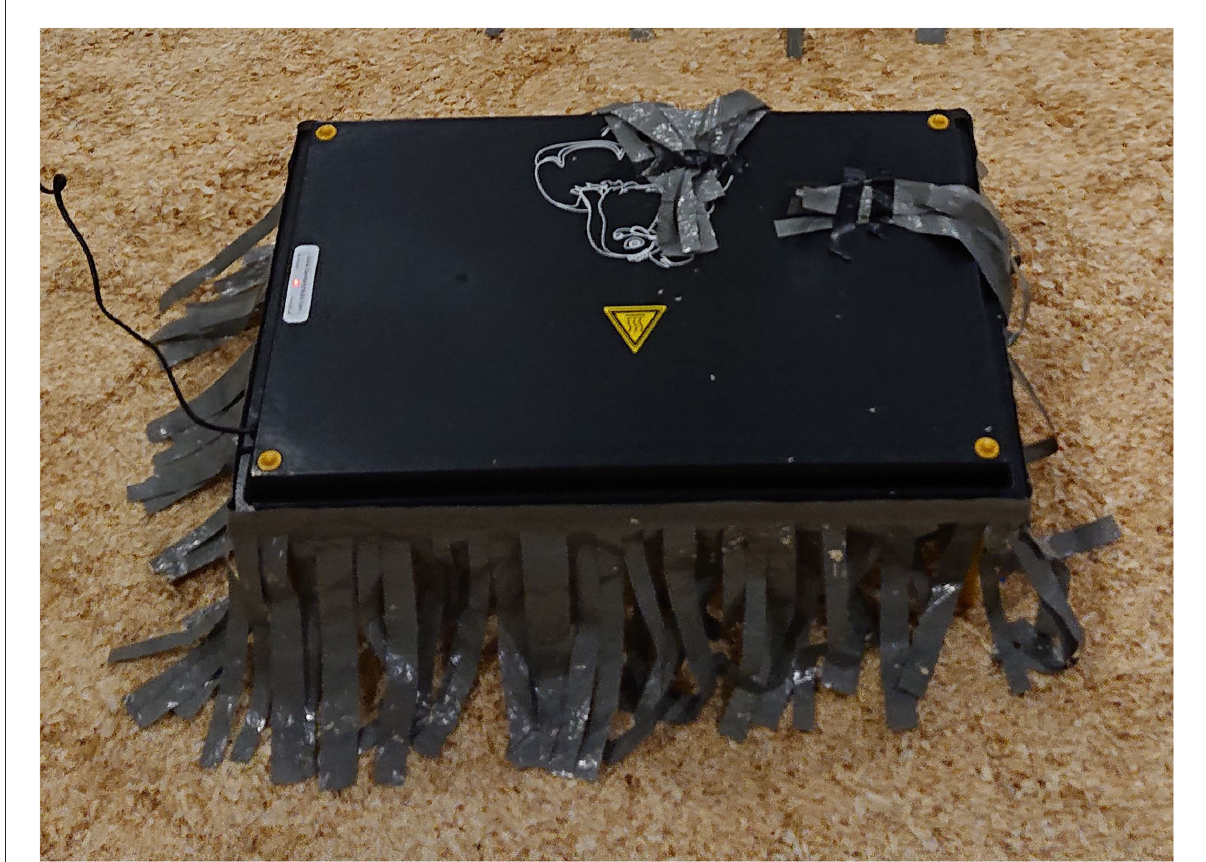
FIGURE2 Artificial brooder with flaps of tarp. The height of the brooders was adjusted during the